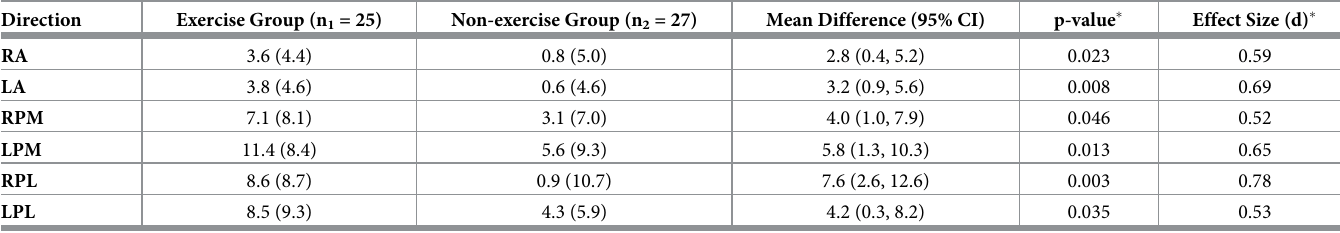
Table 4. Mean (SD) change with 95% CI in reach distance (cm) from baseline to week eight by study group (N = 61).